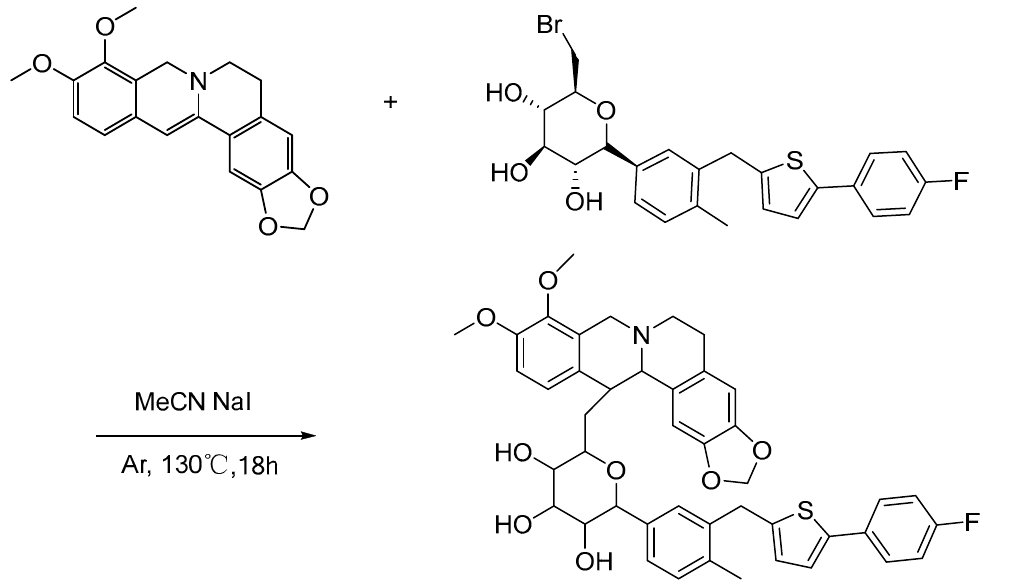
Figure 4. Synthesis of BC. Reagents and conditions: MeCN, NaI, Ar, 130 °C, 18 h.